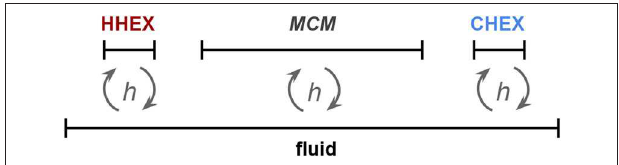
FIGURE 1 | Geometry for the unidimensional active magnetic refrigerator model. The fluid is static, while the MCM, hot and cold heat exchangers (HHEX and CHEX, respectively) moves cyclically in the horizontal direction. Heat is transferred between the fluid and the 3 remaining elements ( h